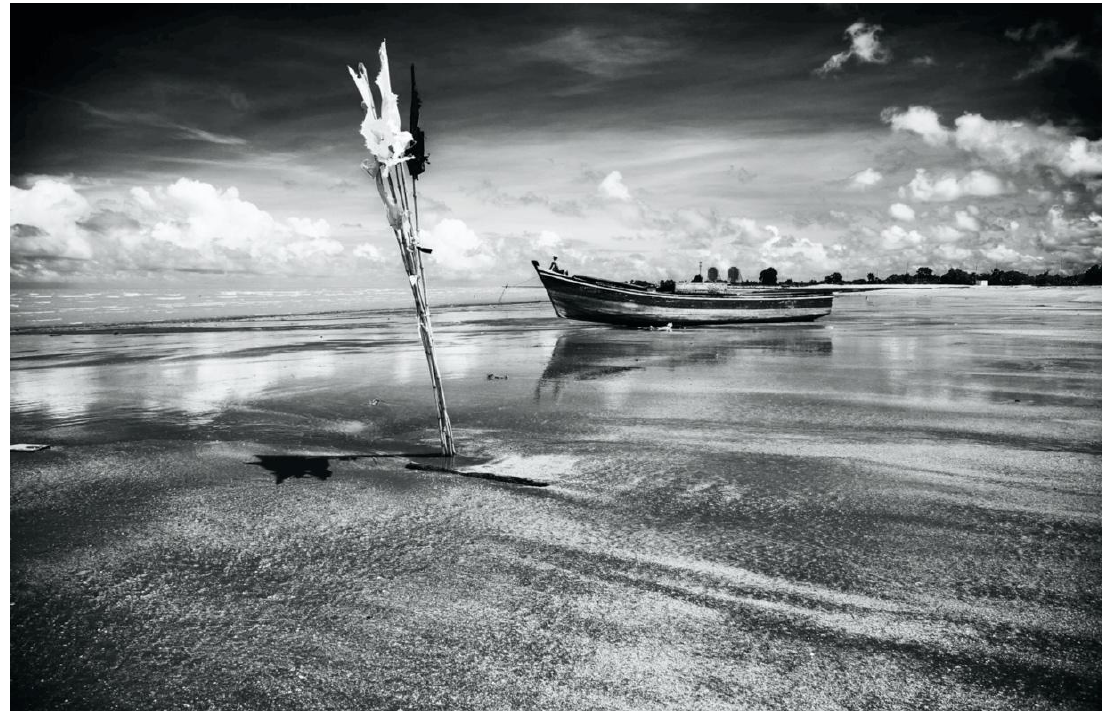
Figure 1. Michael Lam, Seaward Bowline (Georgetown, Guyana), from the series, Oniabo , 2013–pre- sent.